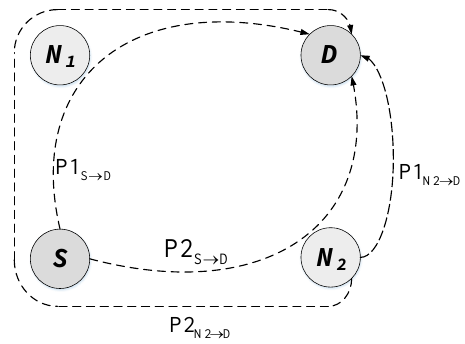
Figure 5. Possible loop creation for low priority packets.